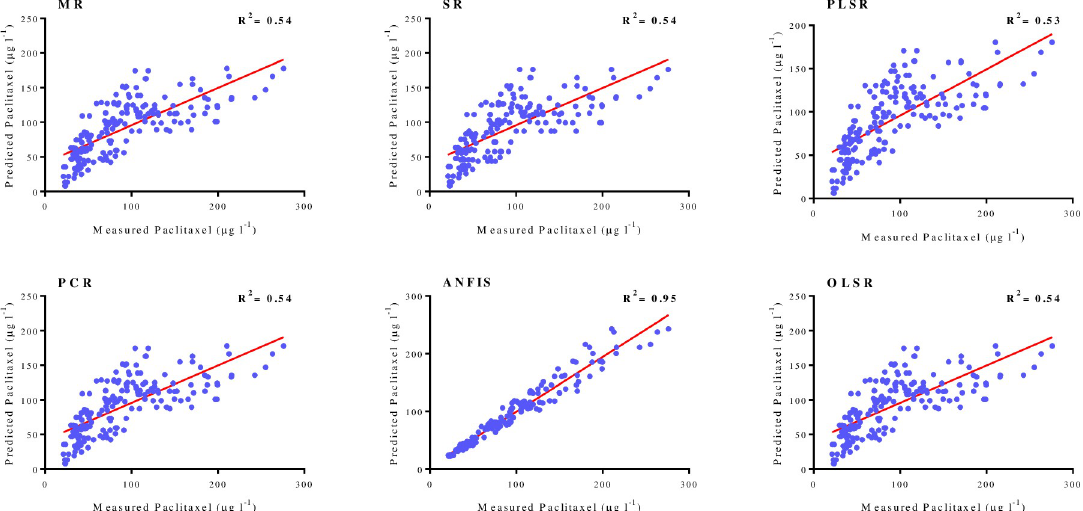
Fig 5. Scatter plot of actual data against predicted values of paclitaxel biosynthesis in Corylus avellana cell cultures exposed with different concentration of fungal culture filtrate (CF), either individually or combined treatment with 50 mM methyl- β - cyclodextrin (MBCD), using adaptive neuro-fuzzy inference system (ANFIS), multiple liner regression (MLR) stepwise regression (SR), ordinary least squares regression (OLSR), principal component regression (PCR) and partial least squares regression (PLSR) models in training subset. The solid line shows fitted simple regression line on scatter